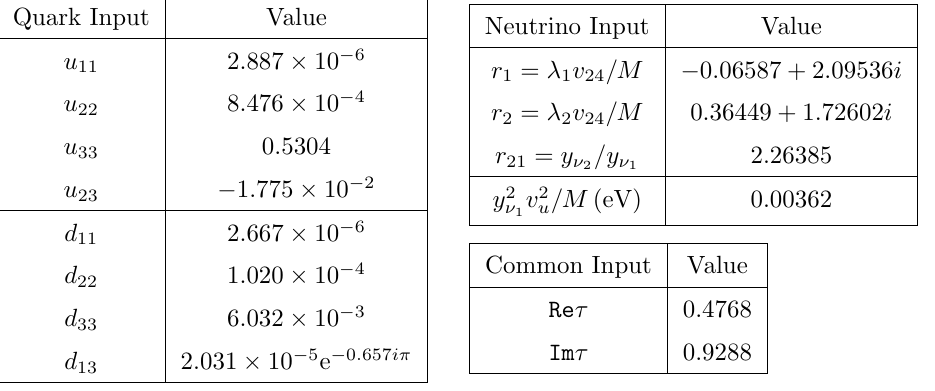
Table 5 . Left panel: the best (cid:12)t input parameters in quark sector. The Yukawa entries u ij and d ij include the original Yukawa coupling coe(cid:14)cients and the modular forms. Upper Right panel: the best (cid:12)t input parameters in neutrino sector. We list the ratios of neutrino couplings in eqs. (3.11) and (3.13). Lower Right panel: the only common input parameter to both sectors is the modulus (cid:28)